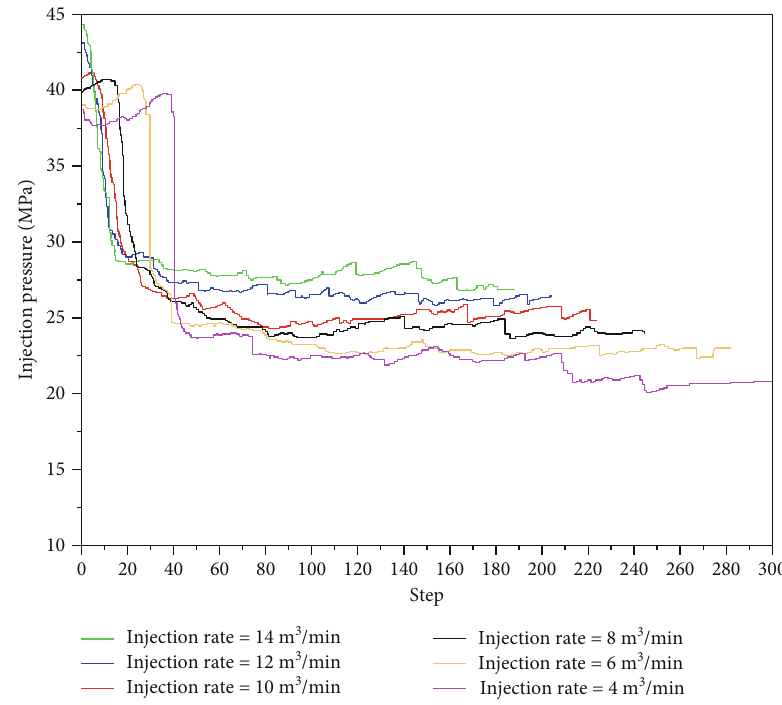
Figure 19: Injection pressure-step curves under di ff erent injection rate.